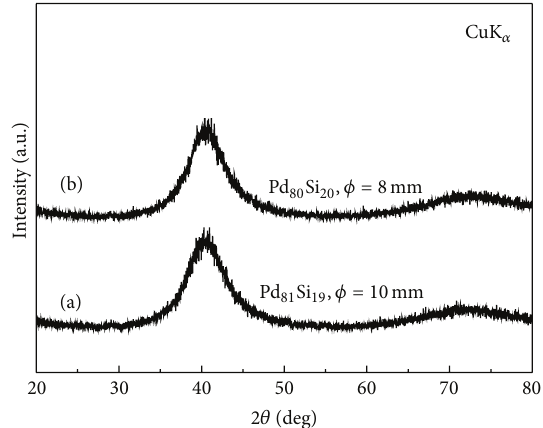
Figure 1: XRD patterns of Pd-Si alloys: (a) Pd 81 Si 19 BMG with a diameter up to 10mm and (b) Pd 80 Si 20 BMG with a diameter up to 8 mm.